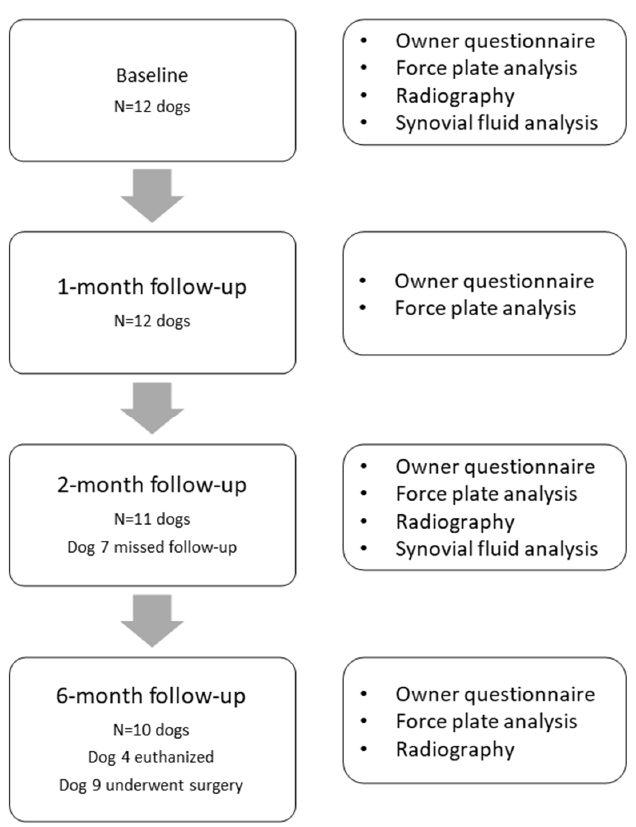
Figure 2. Schematic overview of the veterinary safety and proof-of-concept